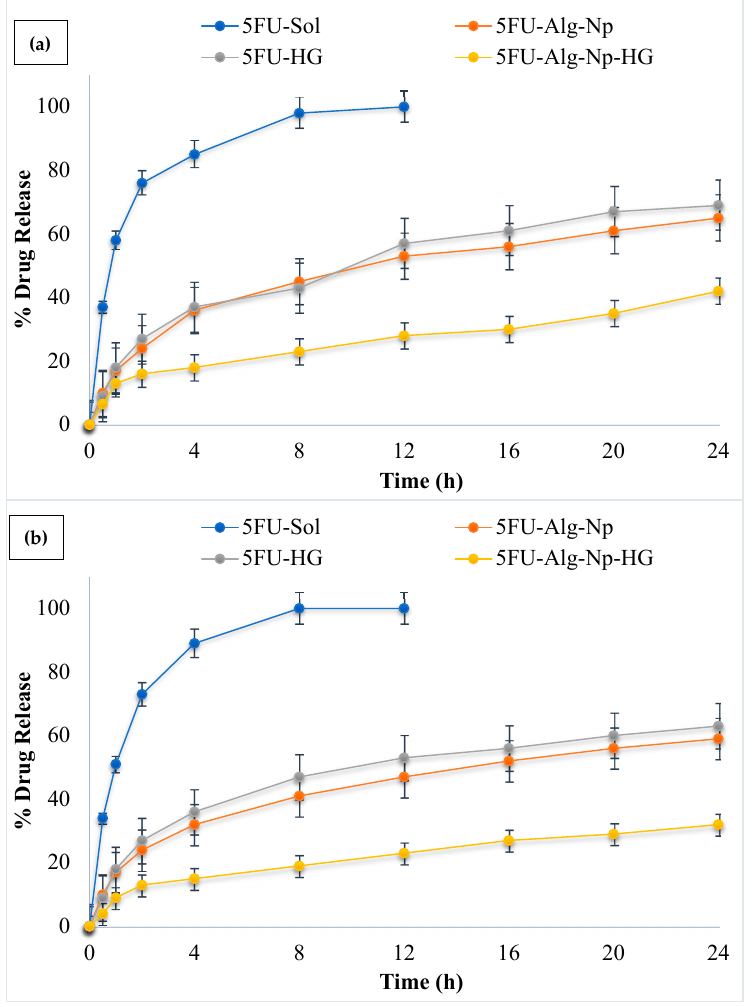
Figure 6. Release profile of 5FU at ( a ) 32 °C and pH 5.5; ( b ) 37 °C and pH 7.4.